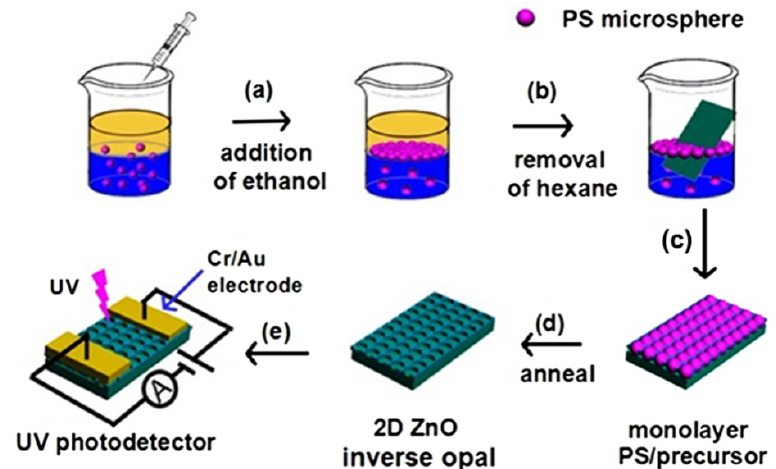
Scheme 1. Schematic illustration for the fabrication of two ‐ dimensional (2D) ZnO inverse opal (IO) film and the corresponding photo ‐ detecting